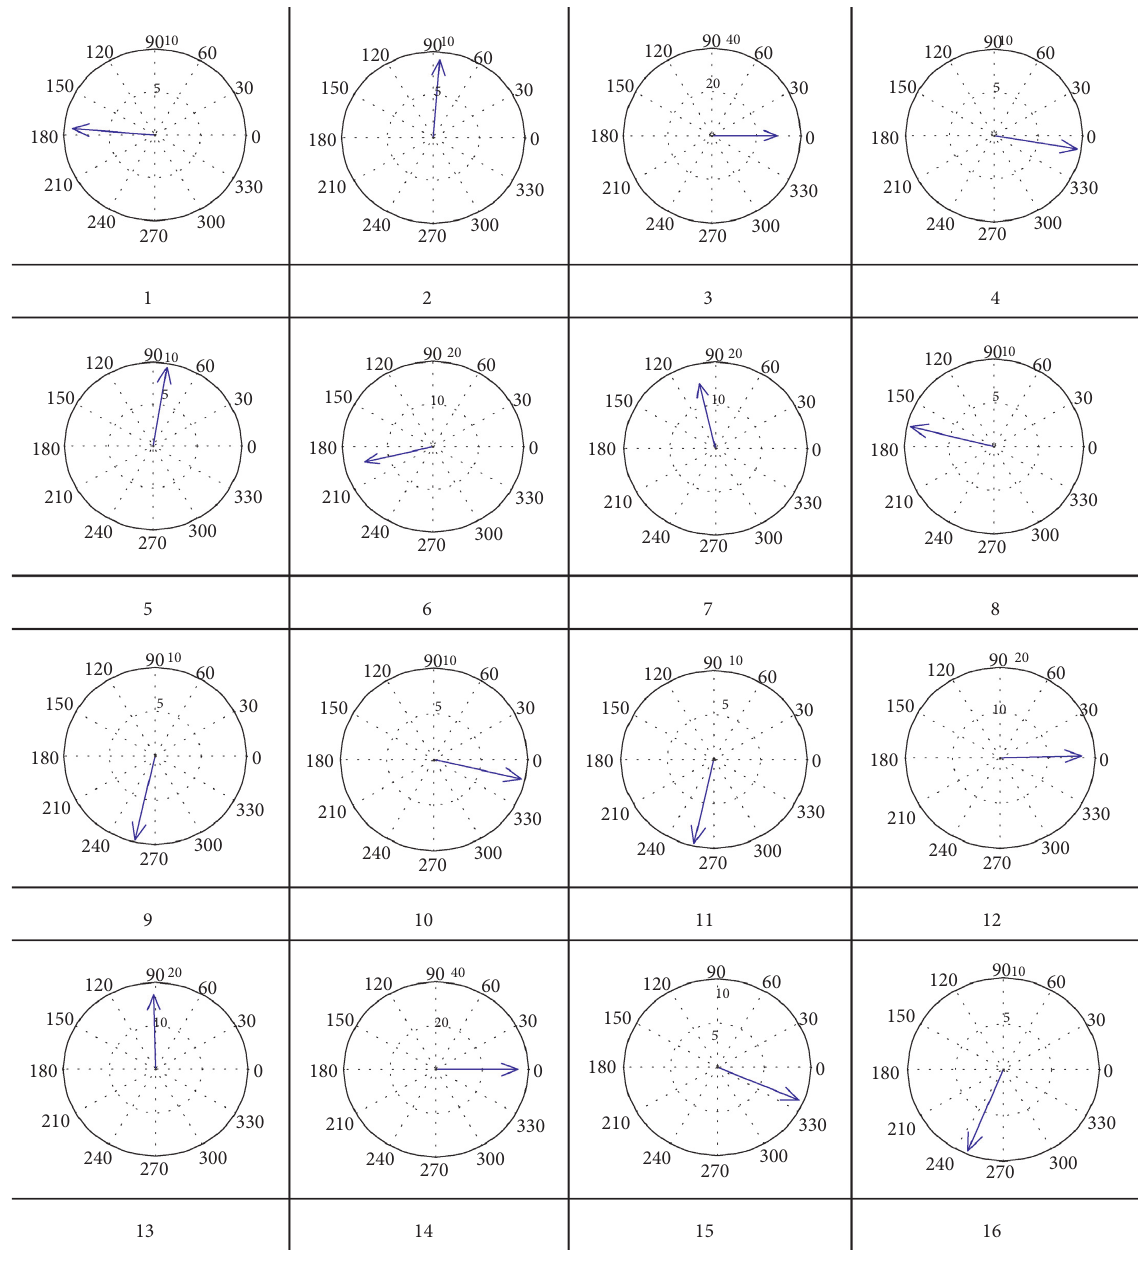
Figure 8: Maximum RTMs. Table 3: Angles between the double